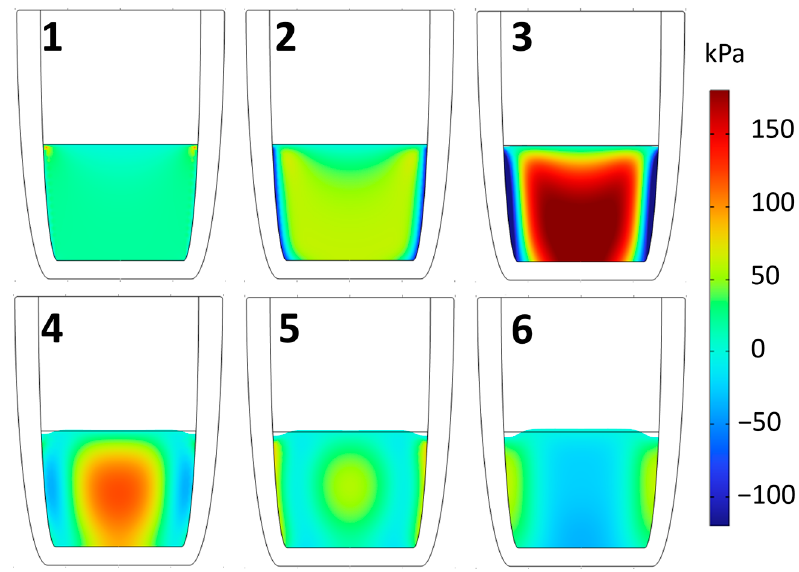
Figure 5. Lorentz force distribution during the first period of the EM pulse: 1—initial, 2—ramp-up, 3—top peak, 4—ramp-down, 5—zero cross, and 6—bottom peak.